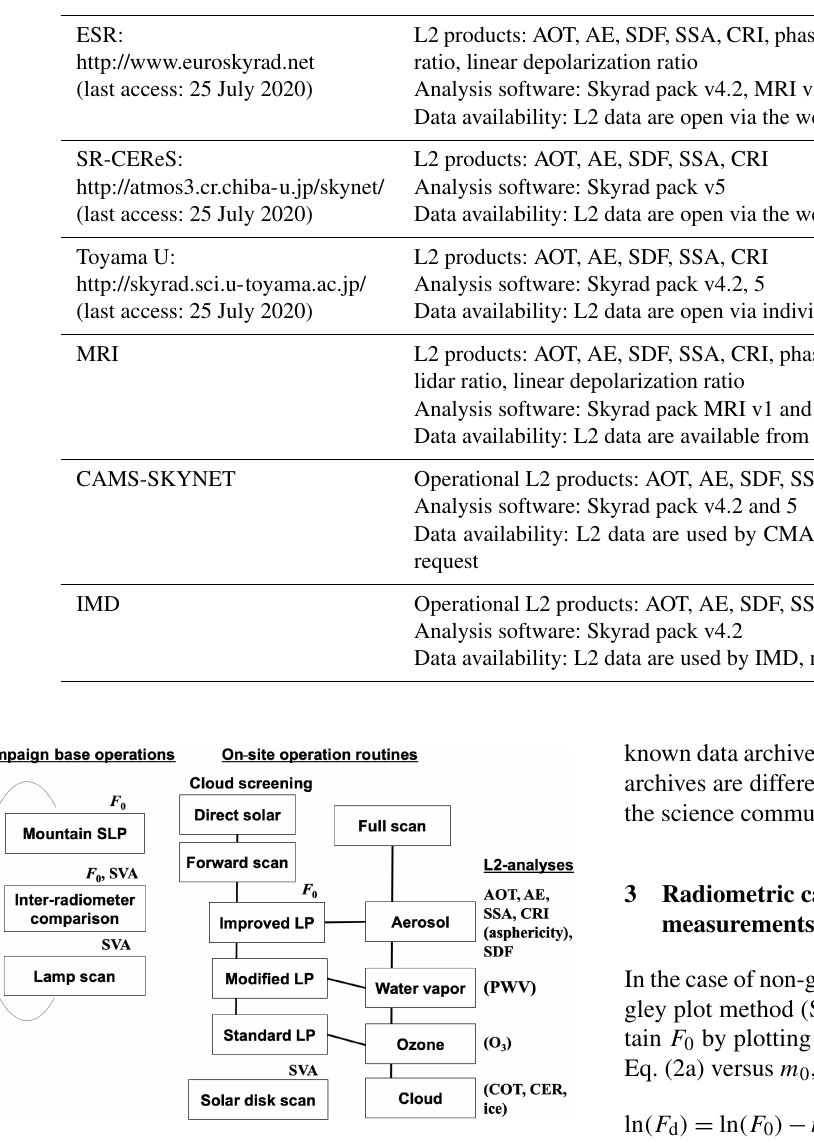
Figure 3. A flowchart of the SKYNET analysis. Quantities in paren- theses are research